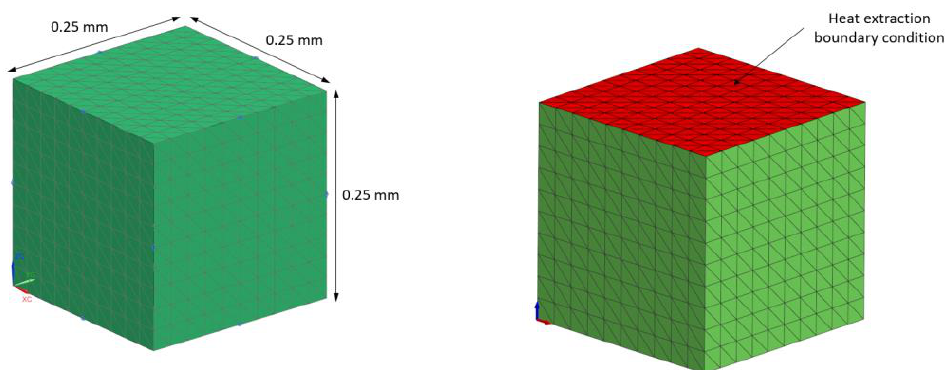
Figure 8. RVE model ( left ). Heat extraction condition ( right ).